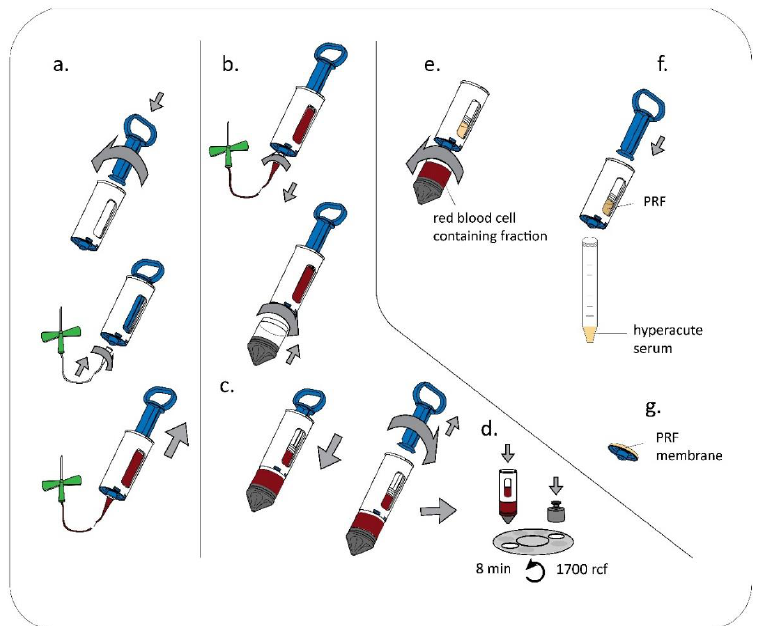
Figure 2. PRF membrane preparation by a single-syringe closed system (hypACT Inject Auto). 18 mL venous blood was taken by venipuncture from healthy volunteers into the hypACT Inject syringe ( a ). The waste container was attached to the syringe ( b ) and the whole blood was pushed down by the plunger manually until the waste container was filled with blood ( c ). The syringe was immediately centrifuged (1700 rcf, 8 min) ( d ). After centrifugation, whole blood became separated to red blood cells and supernatant, the waste container contains the red blood cells, the syringe contains the supernatant. PRF is formed from the supernatant due to natural clotting. After this, the waste container was removed ( e ) and hyperacute serum was pressed out from the syringe by re-attaching and pressing the plunger ( f ). The lower plastic cap, which holds the filter was removed in a sterile laminar flow tissue